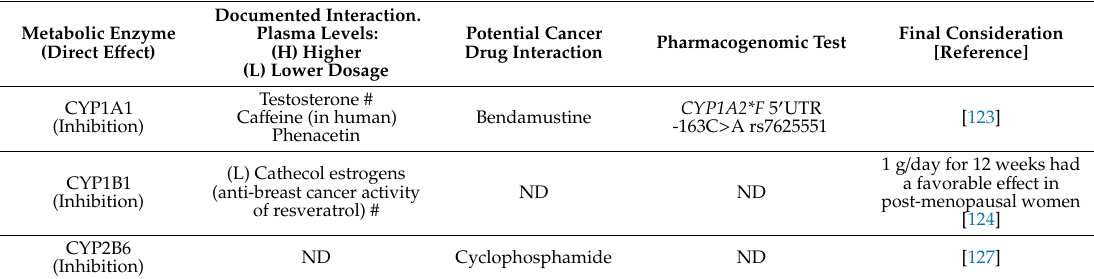
Table 2. Metabolic e ff ects and cancer–drug